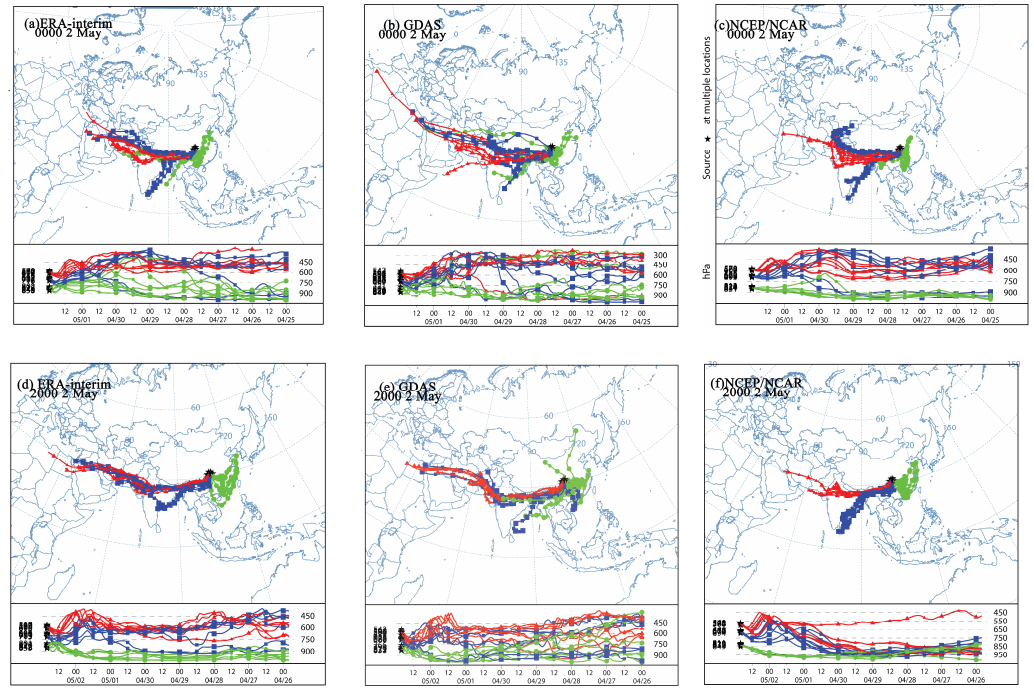
Figure 9. Moisture transportation paths during ( a – c ) the first stage; and ( d – f ) the second stage. The red lines, the blue lines and the green lines denote the transport trajectories of air parcels at 600 hPa, 700 hPa and 850 hPa, respectively.